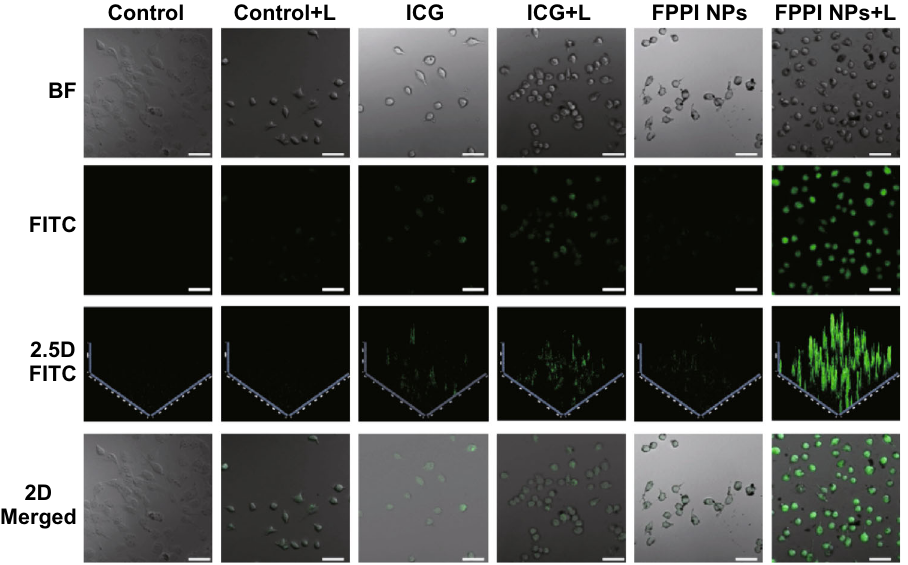
Fig. 5 Detection of intracellular ROS using DCFH-DA probes (FITC channel) after HeLa cells were treated with free ICG and FPPI NPs (at an equivalent ICG concentration of 6 l g mL - 1 ) for 4 h and subjected to NIR irradiation (‘‘L’’) for 10 min where applicable (scale bars: 50 l